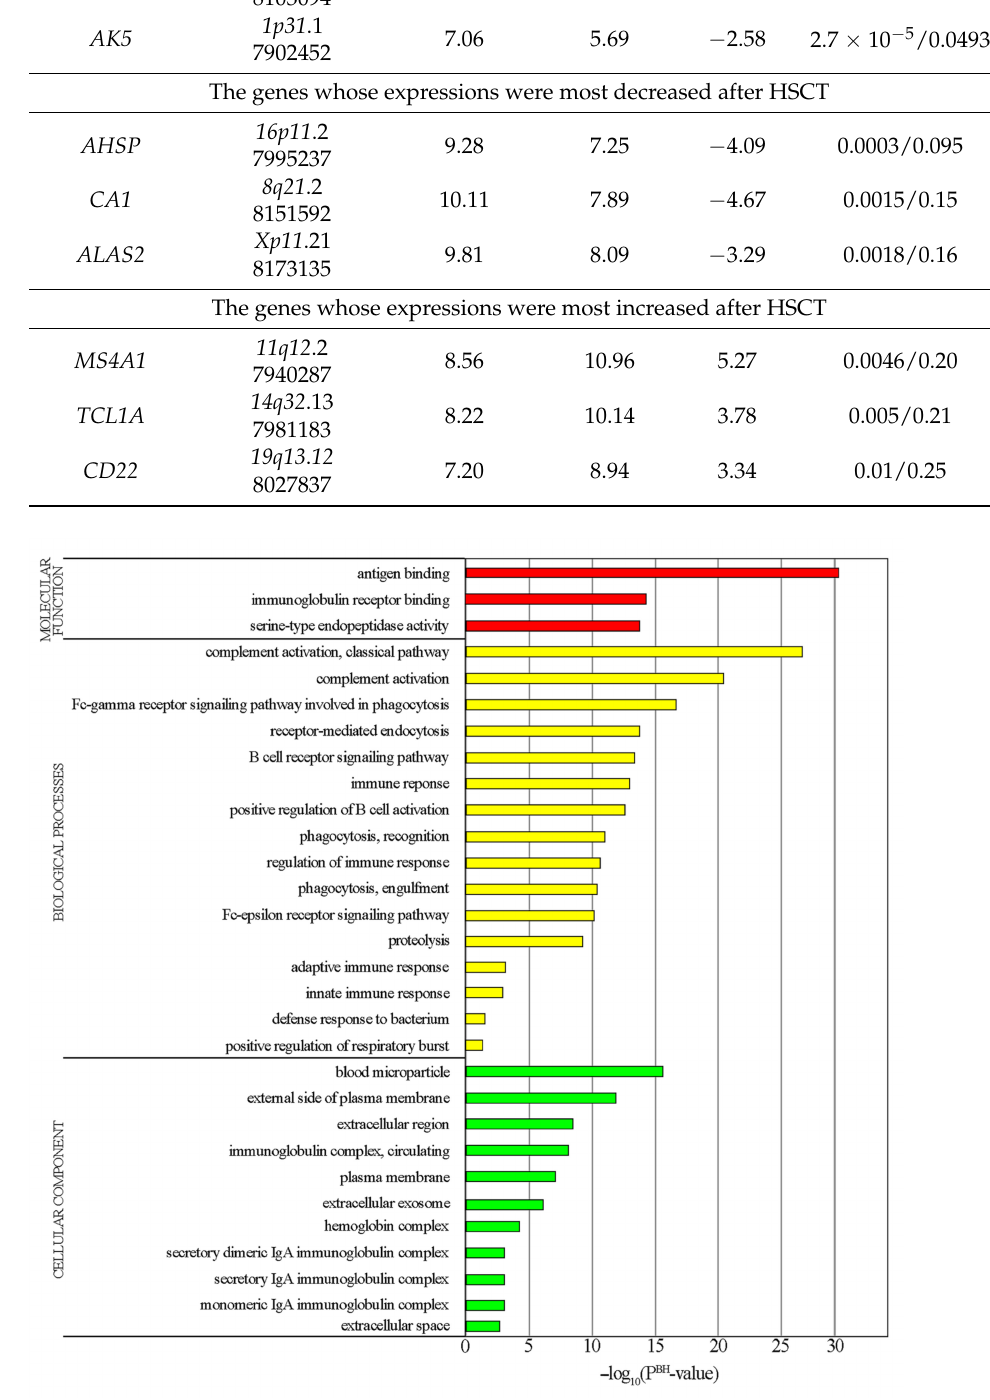
Figure 2. Bar plot showing the analysis of GO enrichment from DEGs between children before and after performing the HSCT procedure. Colors are used only to increase the readability of the figure, i.e., each color represents one of the GO categories, while the length of the bars represents the − log 10 of P BH -Value for given GO